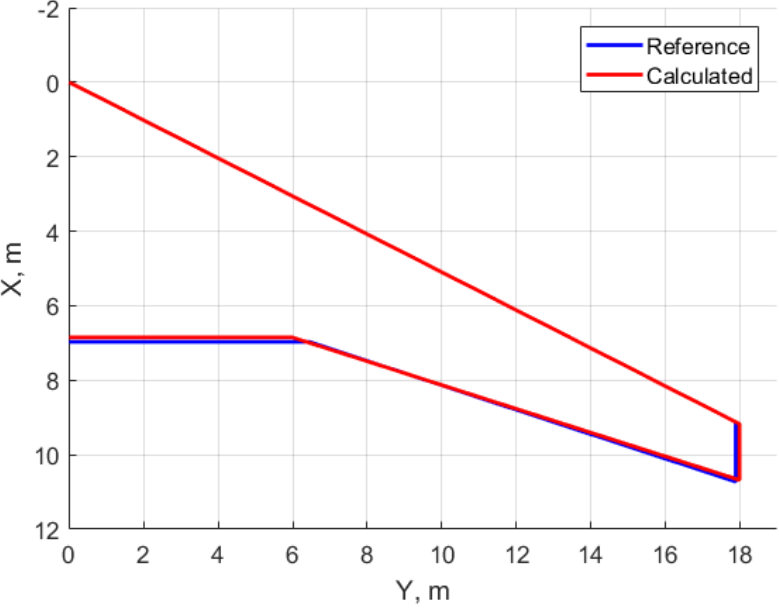
Figure 6. Planform comparison between reference and sized configurations of A320-200. Table 2. Comparison between reference and calculated values of